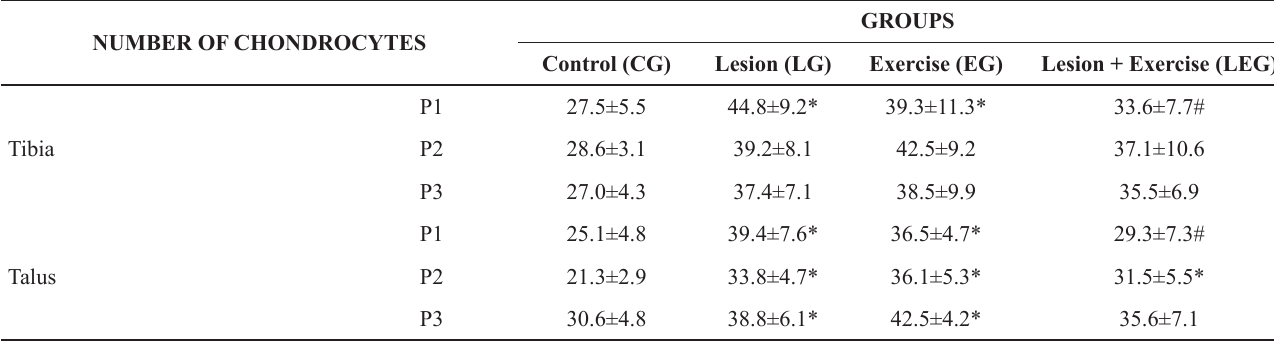
NUMBER OF CHONDROCYTES